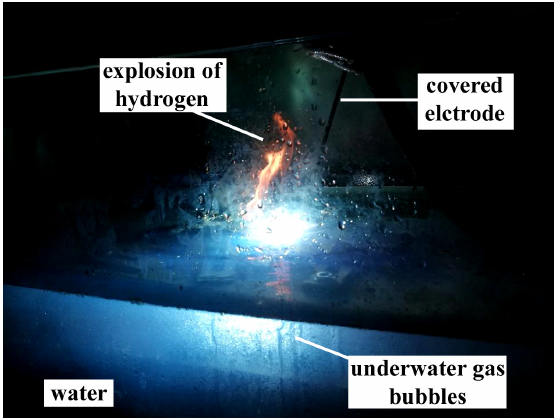
Figure 4. Explosion of hydrogen gas bubble above the water level.